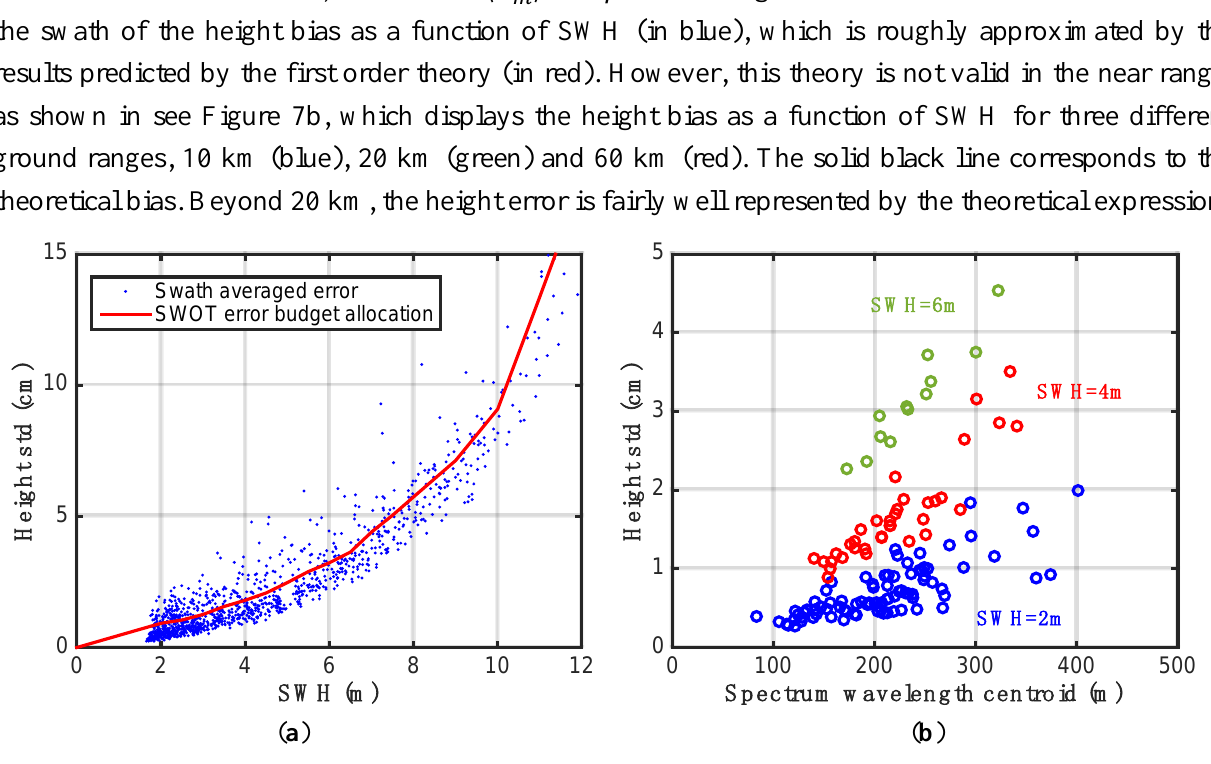
Figure 6. ( a ) Swath average height error for 1 km × 1 km pixels as a function of SWH for multiple WAVEWATCH-III spectra. The red curve is the height error as a function of SWH that is used to project SWOT performance. ( b ) Swath average height error for 1 km x 1 km pixels as a function of the spectrum wavelength